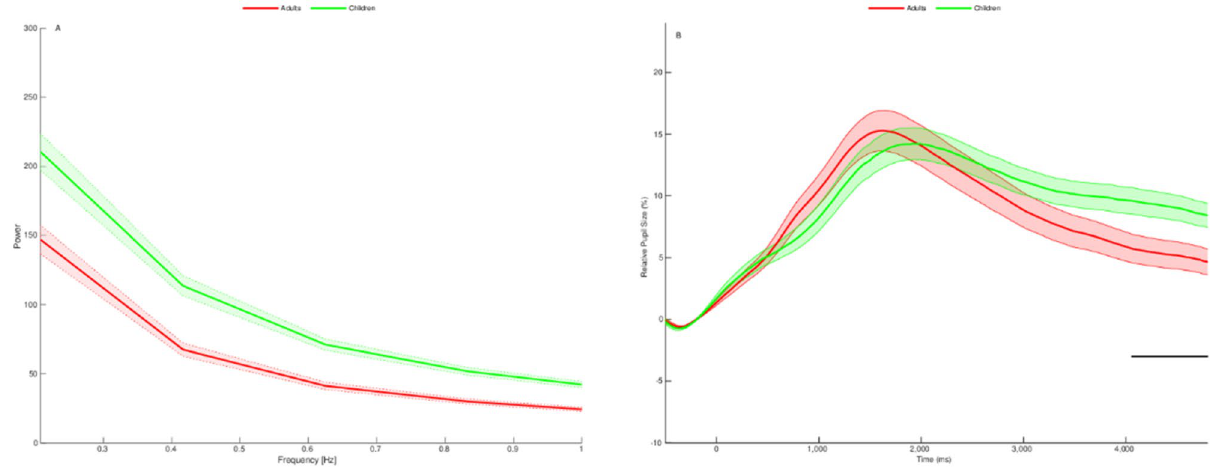
Figure 1. Developmental differences in pupil responses to word reading (real words and pseudowords) between adults and children. ( A ) Power as a function of frequency (smaller than 1 Hz) ( B ) Relative changes in pupil size from stimulus onset (Time 0) to 4800 ms. The shaded areas depict standard errors of the mean.